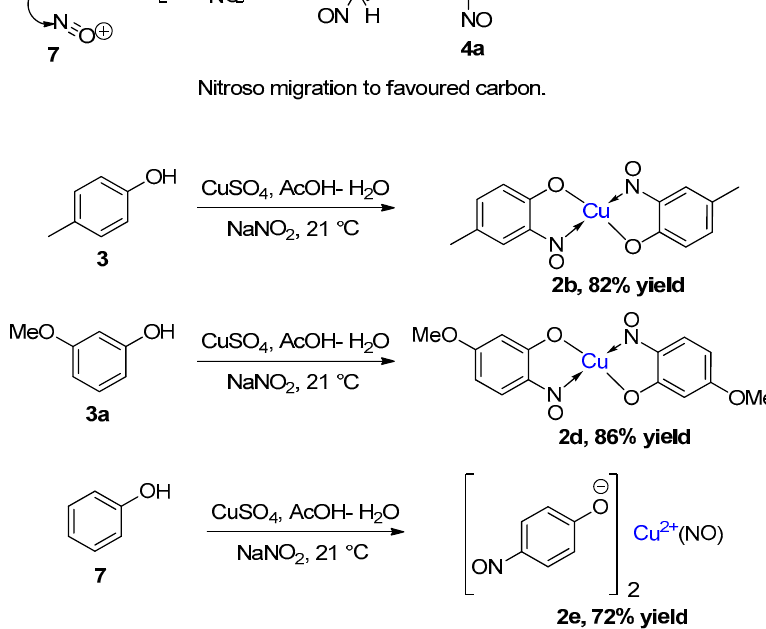
Figure 7. Accepted nitrosation mechanism for phenol in the absence of copper [33,36,63], followed by three examples of our results [41] for copper-mediated nitrosation.